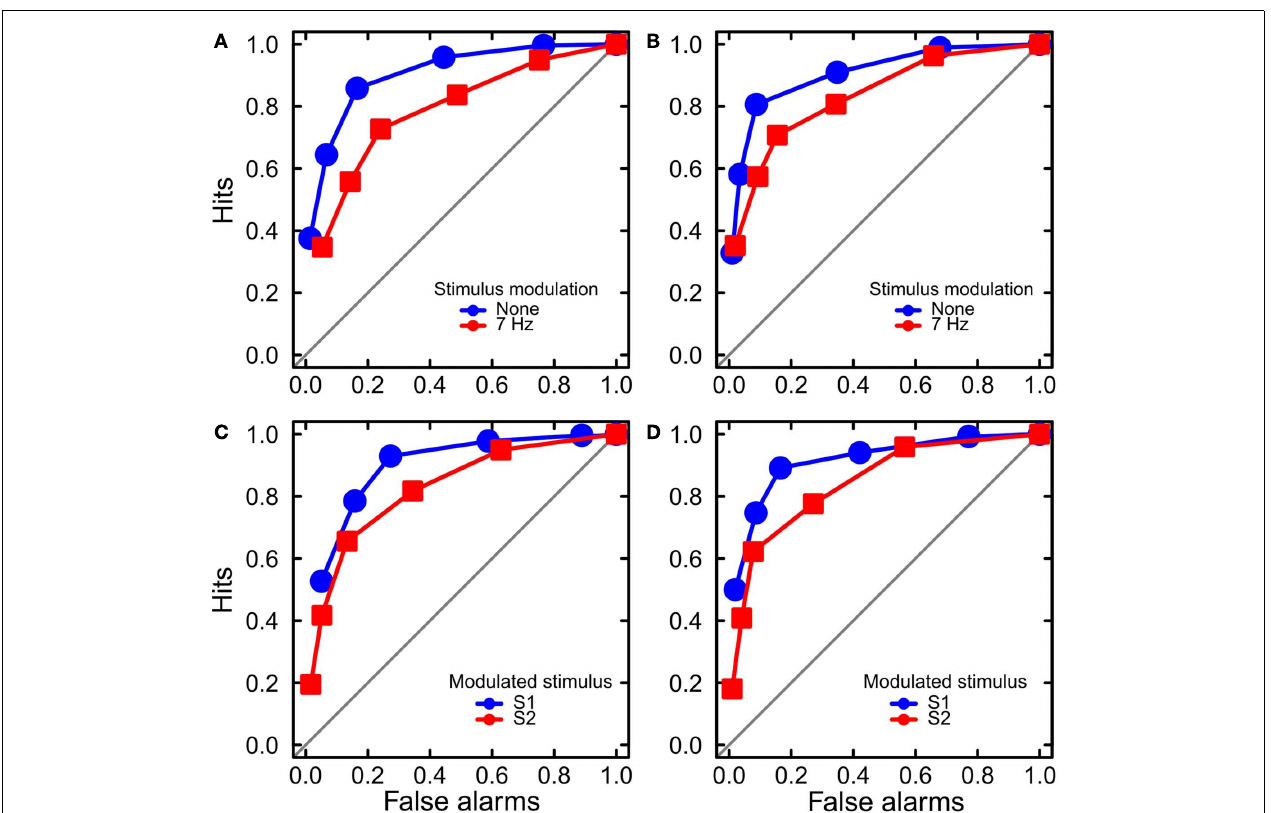
duration.The data are shown separately for the standard durations of 500ms (A) and 1100ms (B) . (C,D) The curves are separated by the factor of stimulus order. Sensitivity was higher for the first (S1) than the second stimulus, for both standard durations of 500ms (C) and 1100ms (D) .